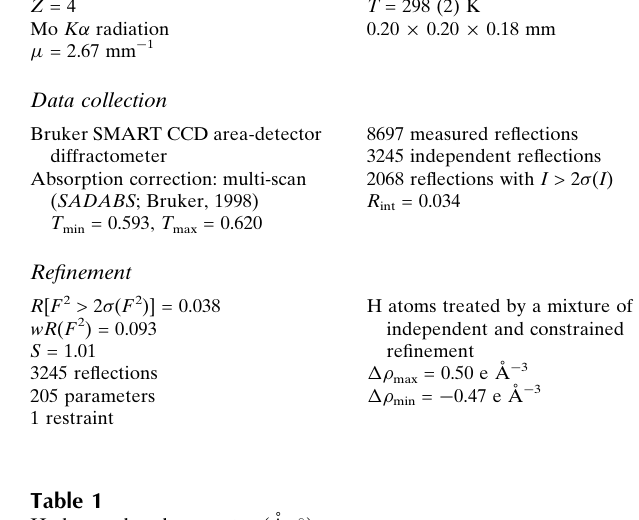
Hydrogen-bond geometry (A˚ , (cid:1)